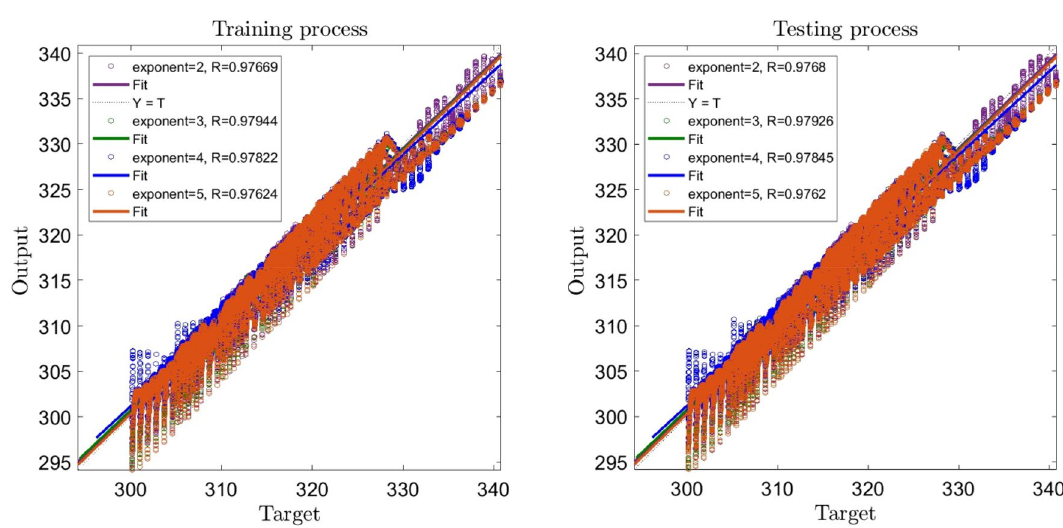
Figure 5. Learning process with changes in exponent as FCM clustering parameter